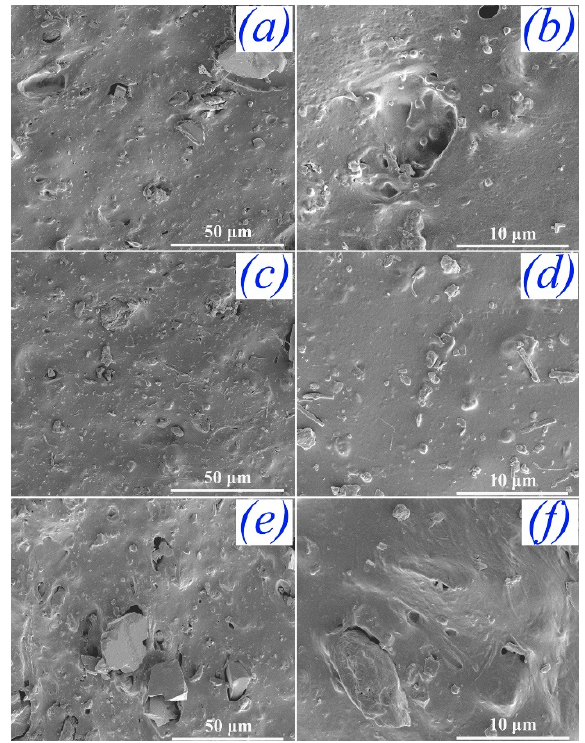
Figure 6. FE-SEM images of the fractured surface of the NR composites with different mFD content (phr). ( a ) and ( b ) phr is 10; ( c ) and ( d ) phr is 30; ( e ) and ( f ) phr is 50.